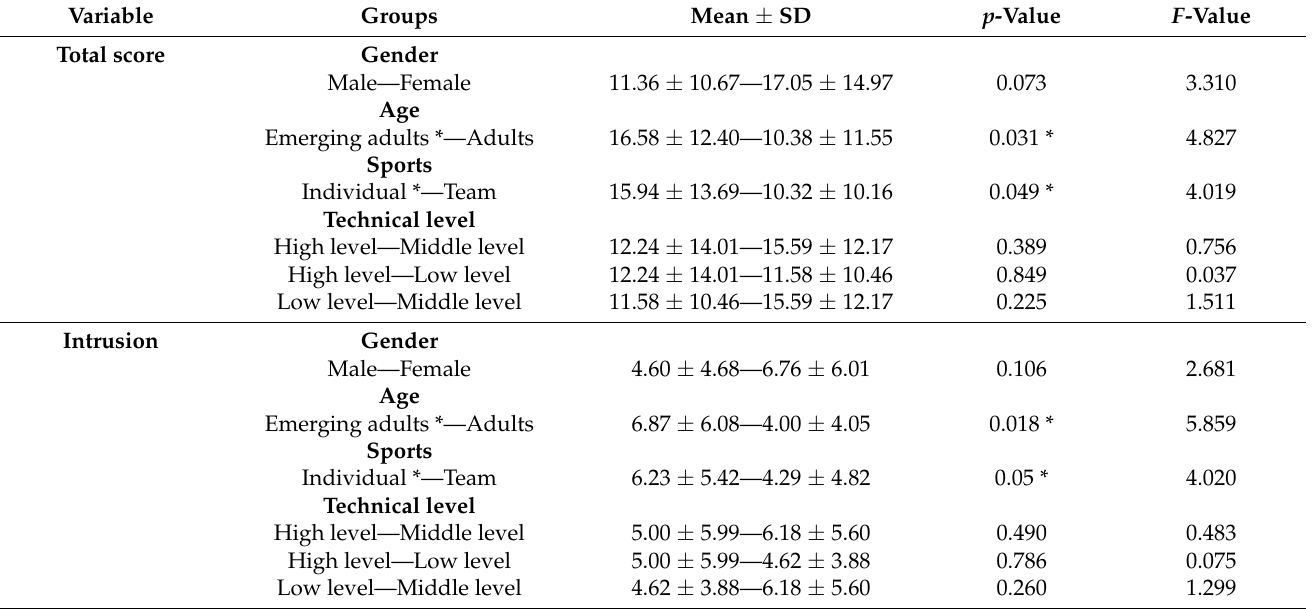
Table 3. Comparison among disabled athletes for IES-R total score and IES-R subscales.